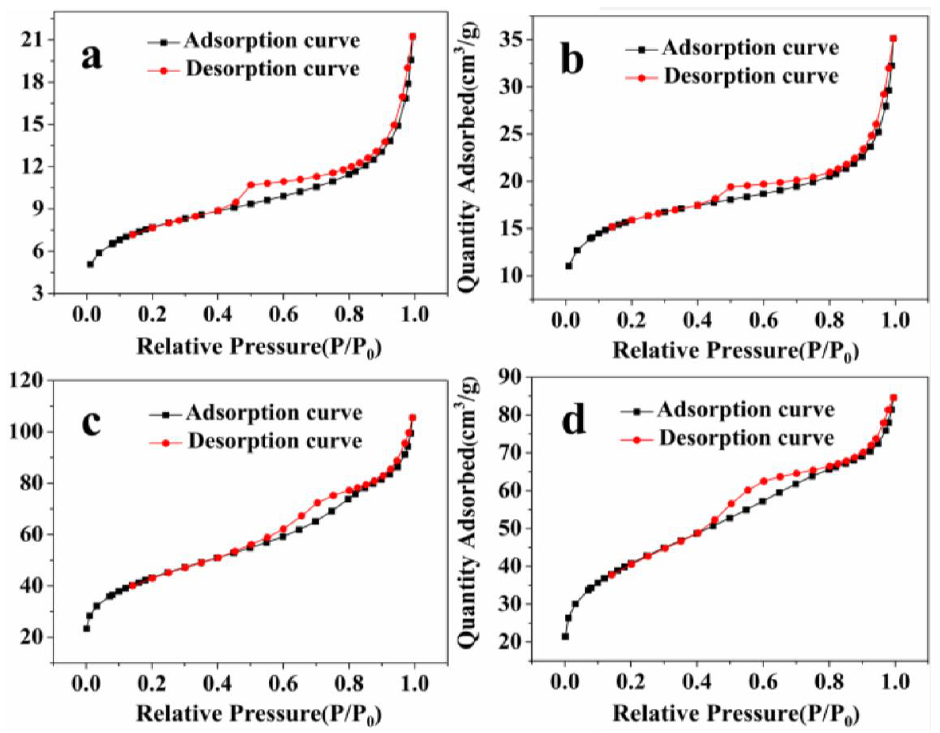
Figure 9. N 2 absorption-desorption isotherms of the products prepared under different solvothermal reaction times: ( a ) 1 h; ( b ) 3 h; ( c ) 6 h; ( d ) 12 h.